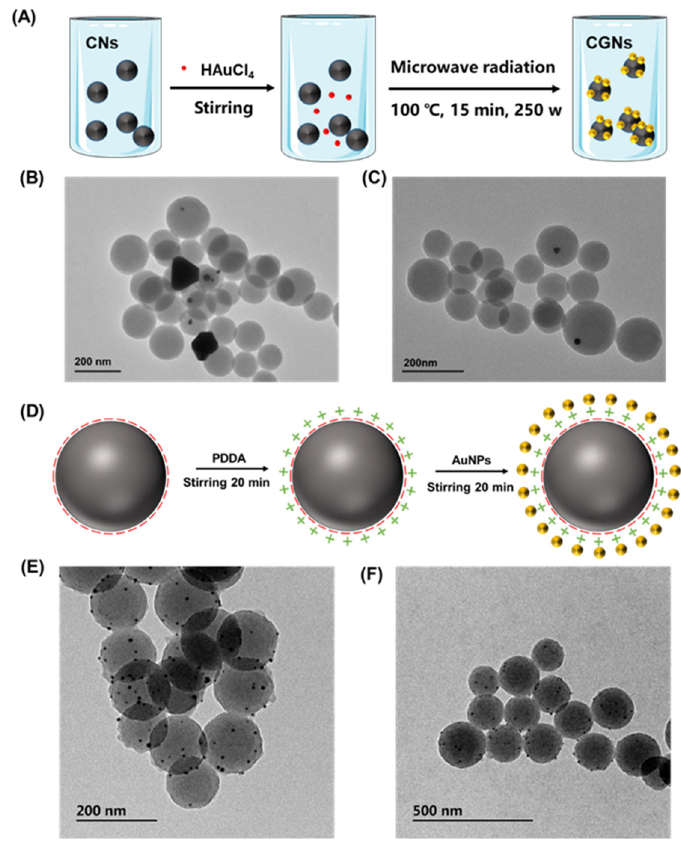
Figure 3. Synthesis of CGNs by microwave method and electrostatic adsorption method. ( A ) Sche- matic illustration of AuNPs deposited on CNs by microwave method, and ( B , C ) the corresponding TEM images of the synthesized CGNs. ( D ) Schematic illustration of AuNPs deposited on CNs by electrostatic adsorption method, and ( E , F ) the corresponding TEM characterization of the prepared CGNs.